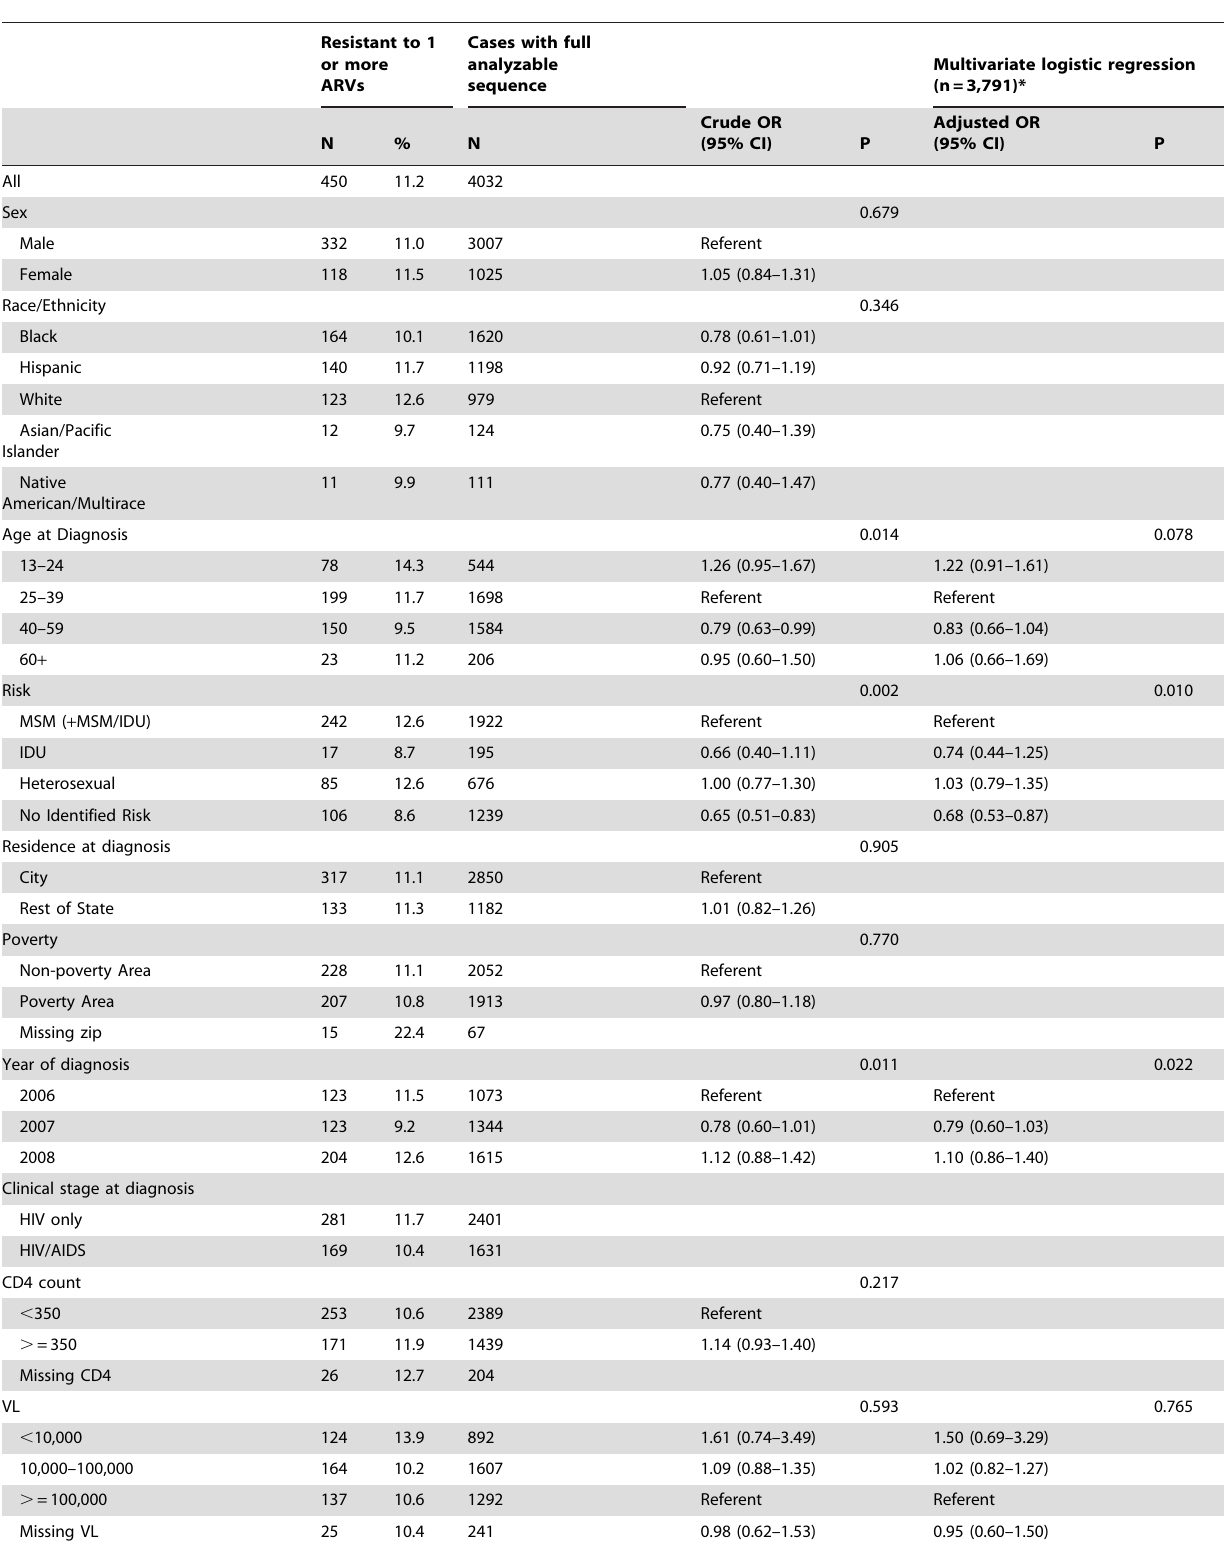
Table 2. Frequency of TDR genotypes by demographic characteristics, New York State